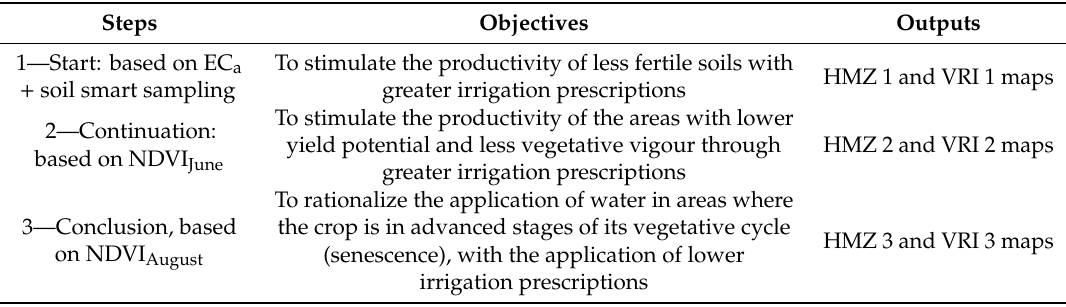
Table 1. Steps, objectives, and expected results of homogeneous management zones (HMZ) and variable rate irrigation (VRI) maps.